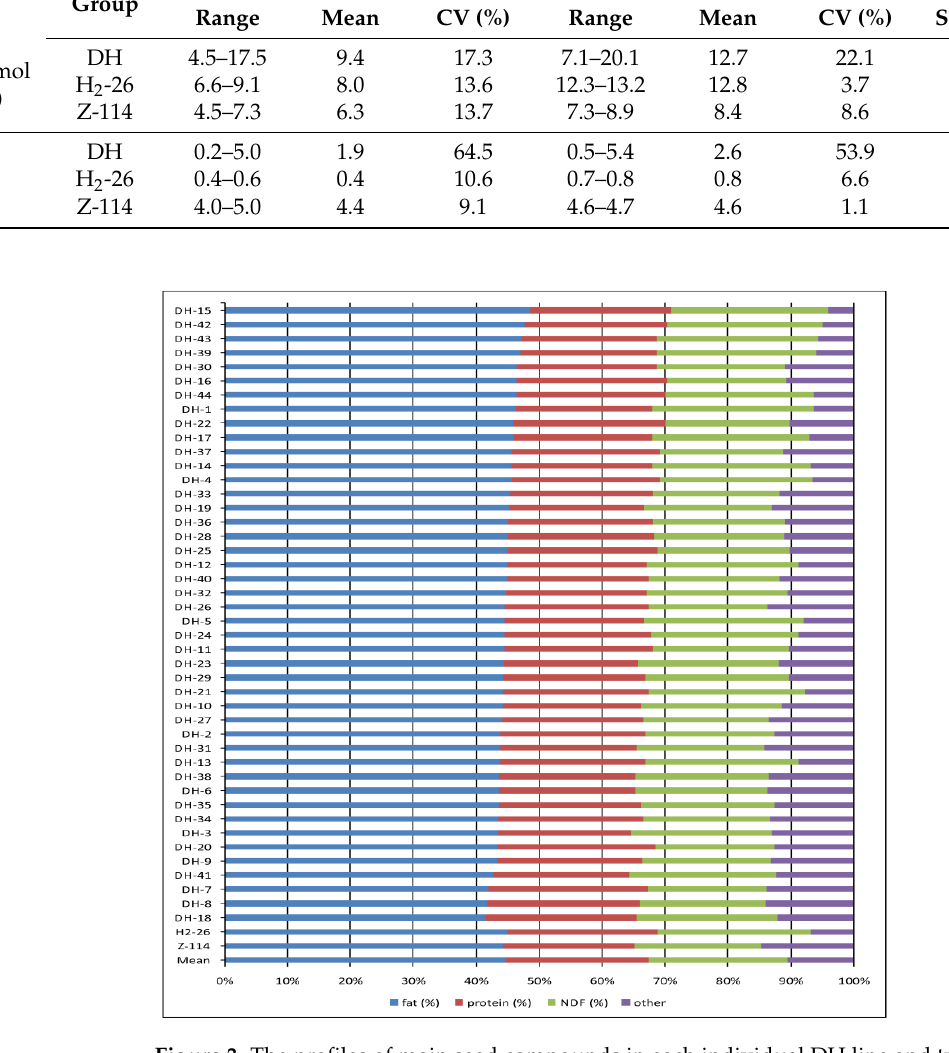
Figure 3. The profiles of main seed compounds in each individual DH line and two parental oilseed rape lines included in the study. The population mean was also shown.